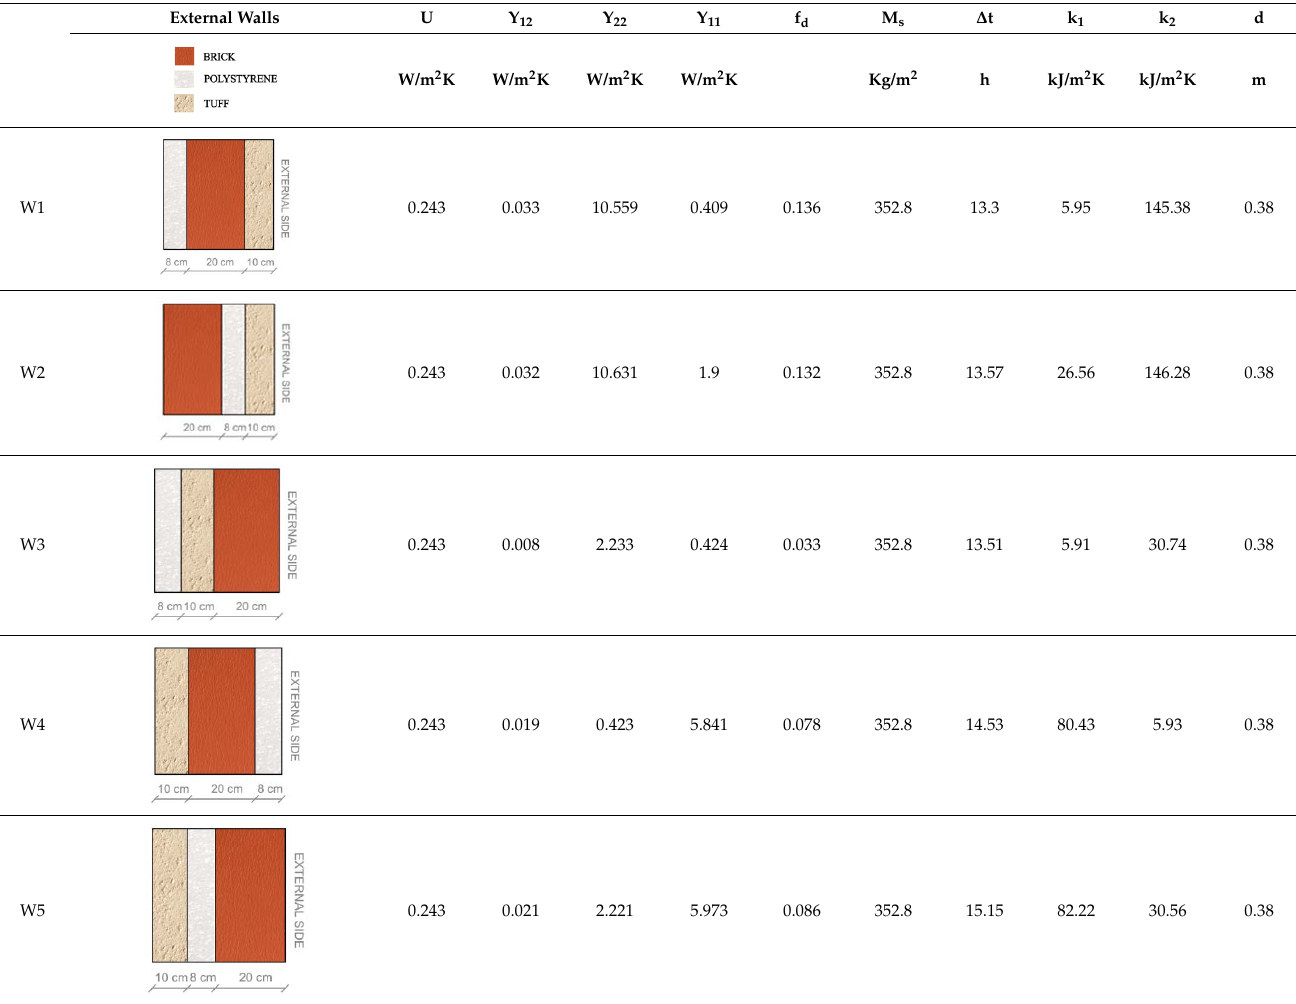
Table 5. External walls evaluation.